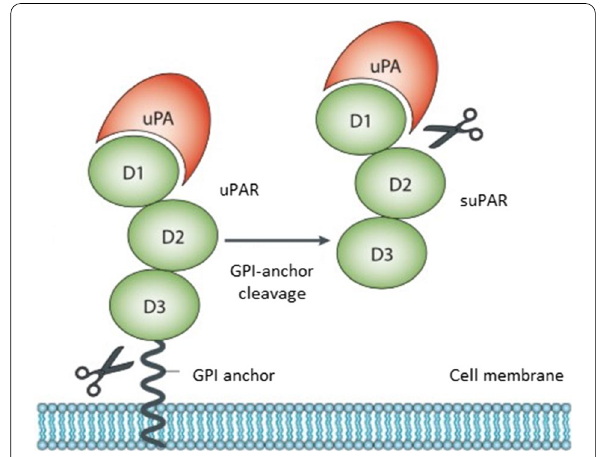
Fig. 1 Molecular structure of uPA